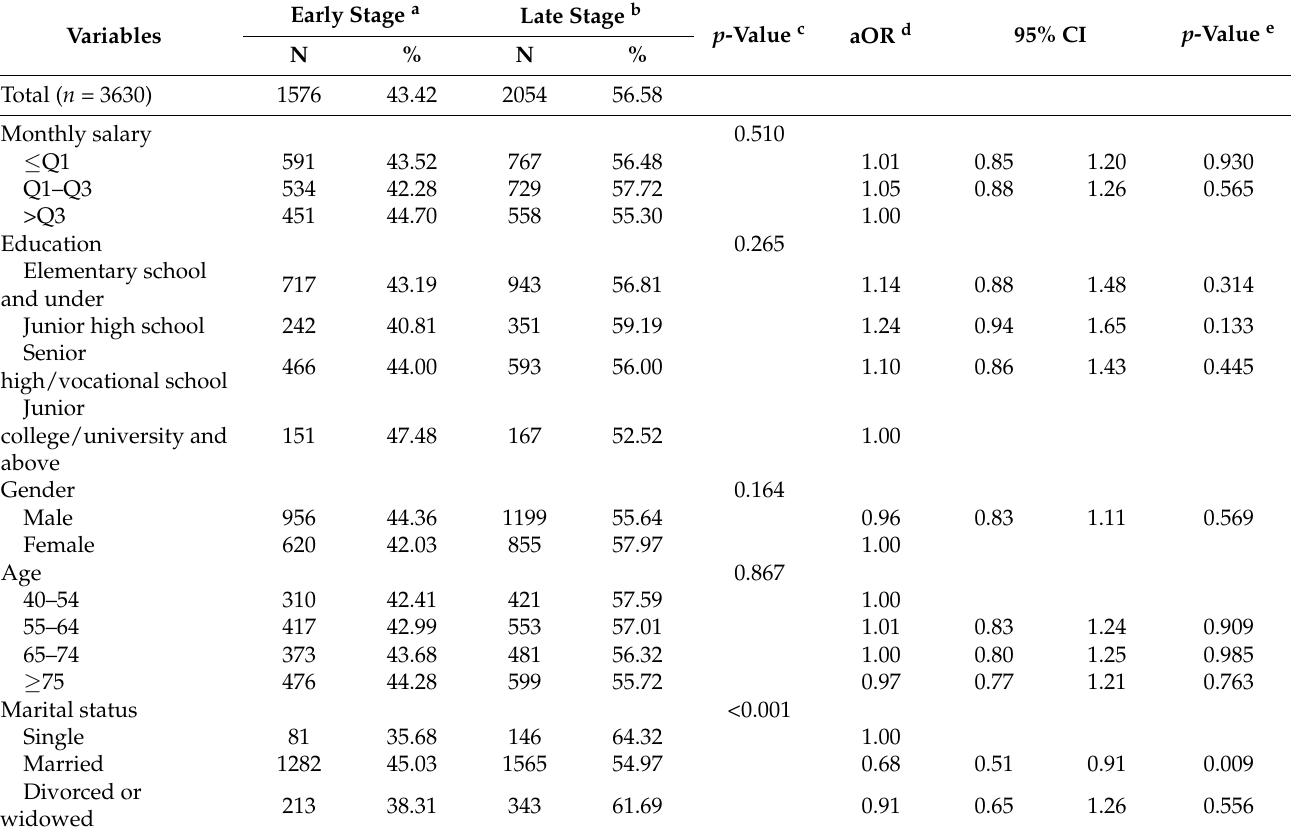
Table 4. Relative risks of suffering from colorectal cancer with late-stage and relevant